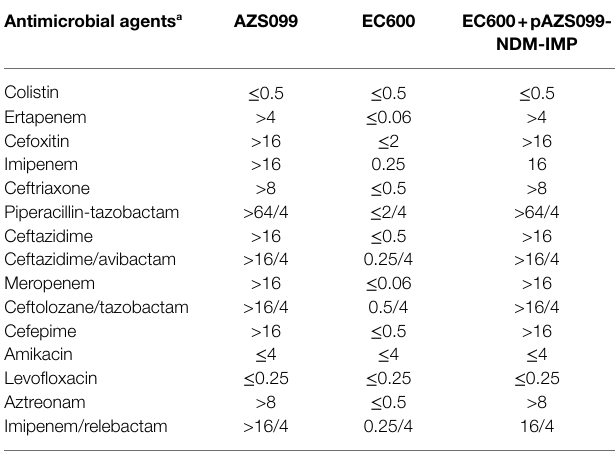
TABLE 1 | The minimum inhibitory concentration (MIC) of the clinical strain AZS099 and EC600 with/without plasmid AZS099-NDM-IMP. Antimicrobial agents a AZS099 EC600 + pAZS099-